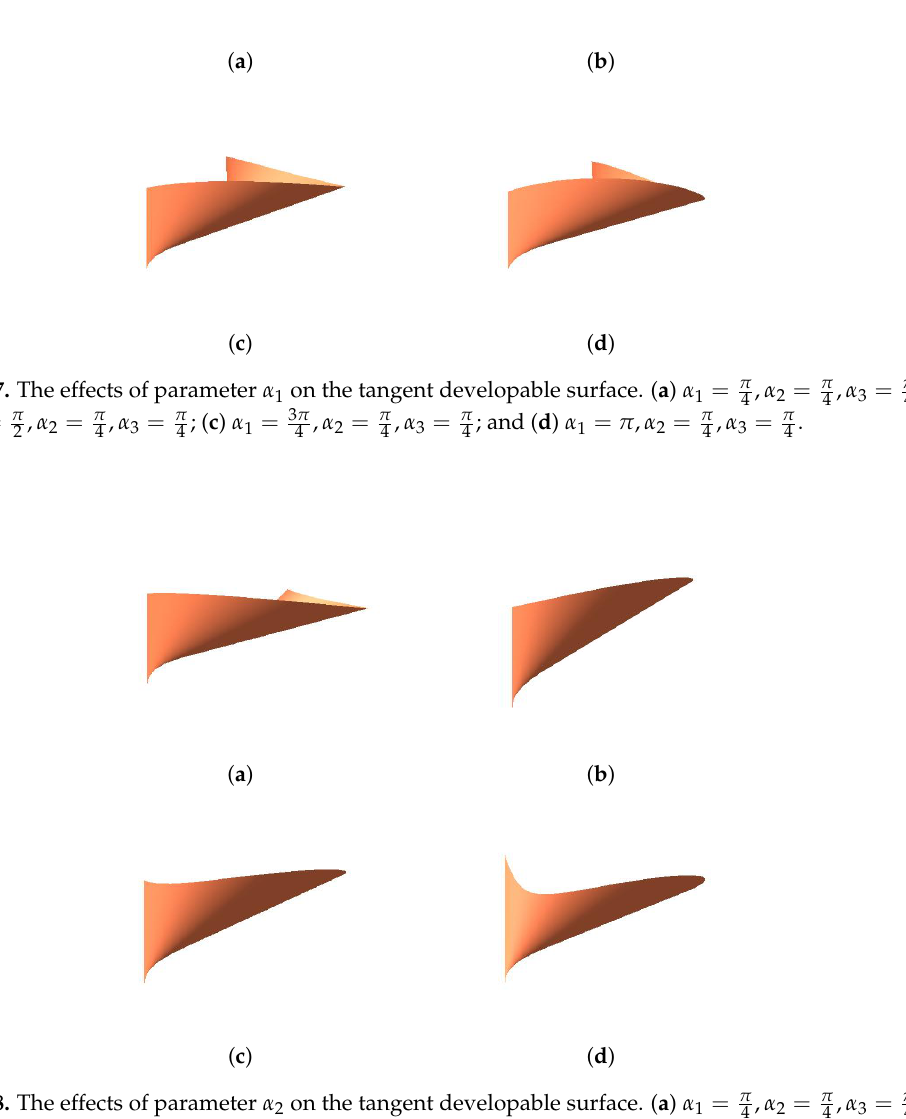
, α 2 = π , α 3 = π ; ( c ) α 1 = π 2 4 4